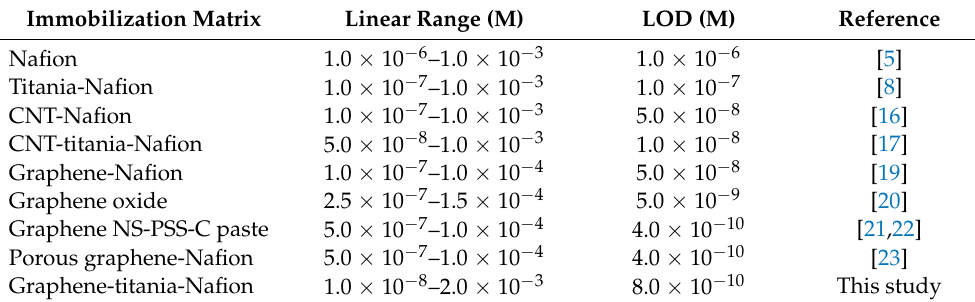
Figure 7. Calibration curve for TPA obtained at the Ru(bpy) 32+ ECL sensor based on the graphene- titania-Nafion composite in 0.05 M PBS at pH 7.0 with a scan rate of 100 mV/s. Inset: concentration range from 1.0 × 10 − 8 M to 5.0 × 10 − 7 M. Table 1. Comparison of the analytical performance of the Ru(bpy) 32+ ECL sensors based on different immobilization